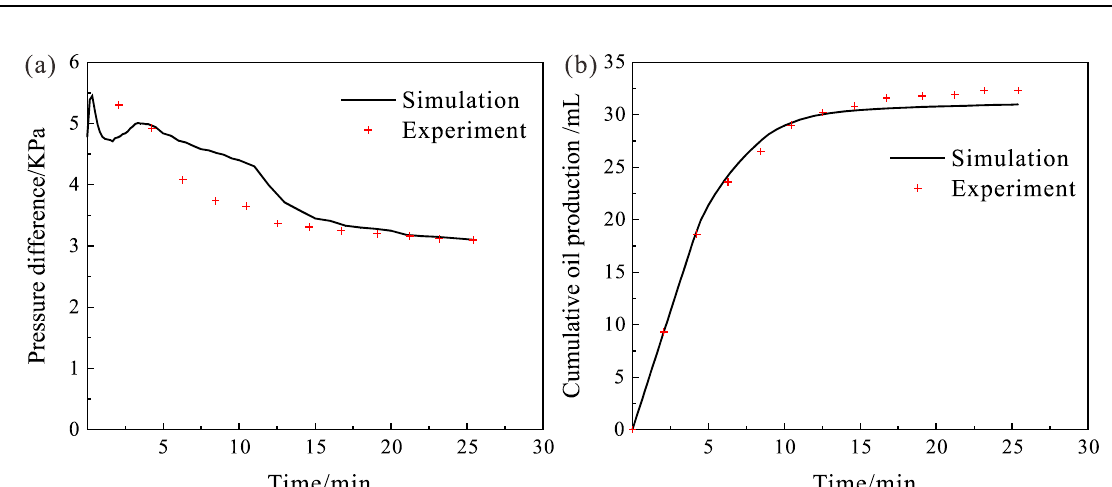
Figure 13. Comparison of the result of experiment and numerical simulation for Case 2 (flow direction is horizontal): ( a ) Pressure drop across the model and ( b ) volume of cumulative produced oil.